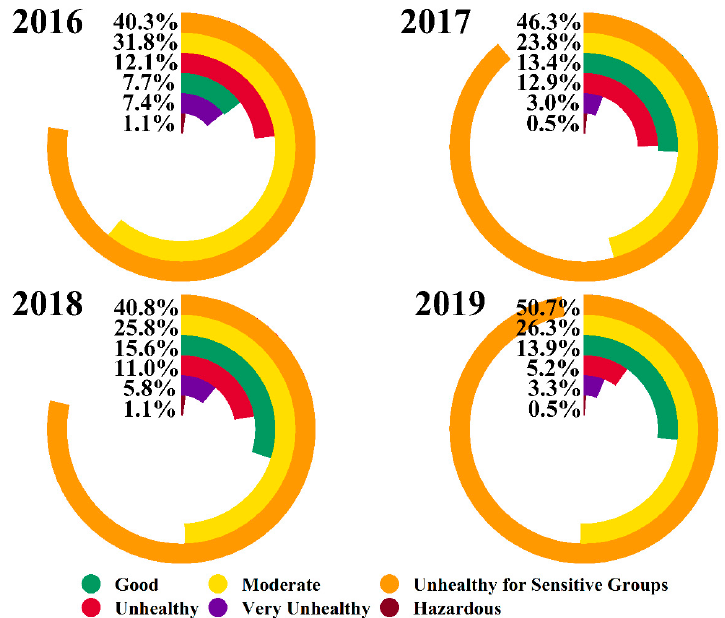
Figure 3. Percentages of days with different levels of air quality in UB from 2016 to 2019.